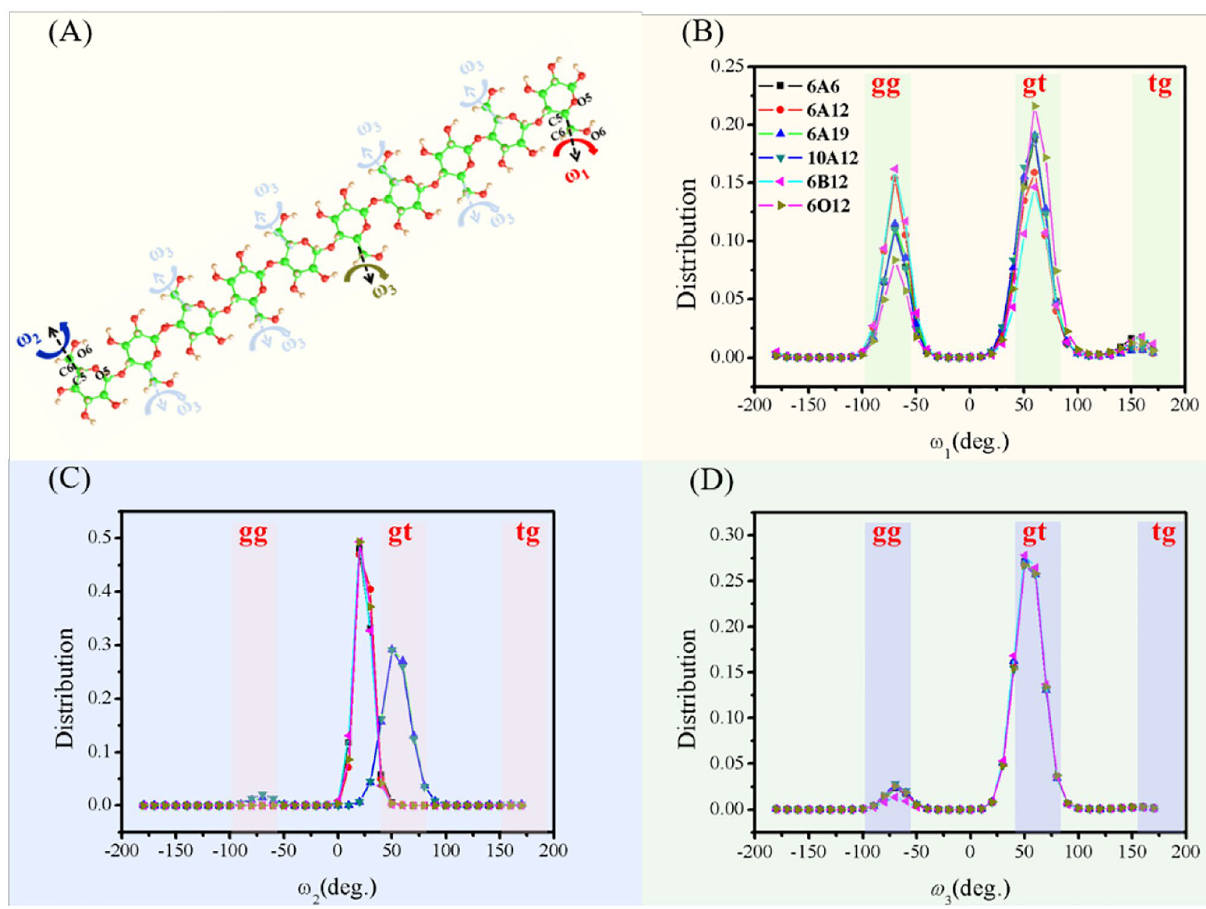
Figure 3. The characteristic dihedral angle O 5 -C 5 -C 6 -O 6 distribution in the MD process. ( A ) Definition of the torsion angle parameters of the hydroxymethyl group; ( B – D ) are the dihedral angles ω 1 , ω 2 and ω 3 distributions of the residues extracted from the MD trajectories in the last 1 ns,